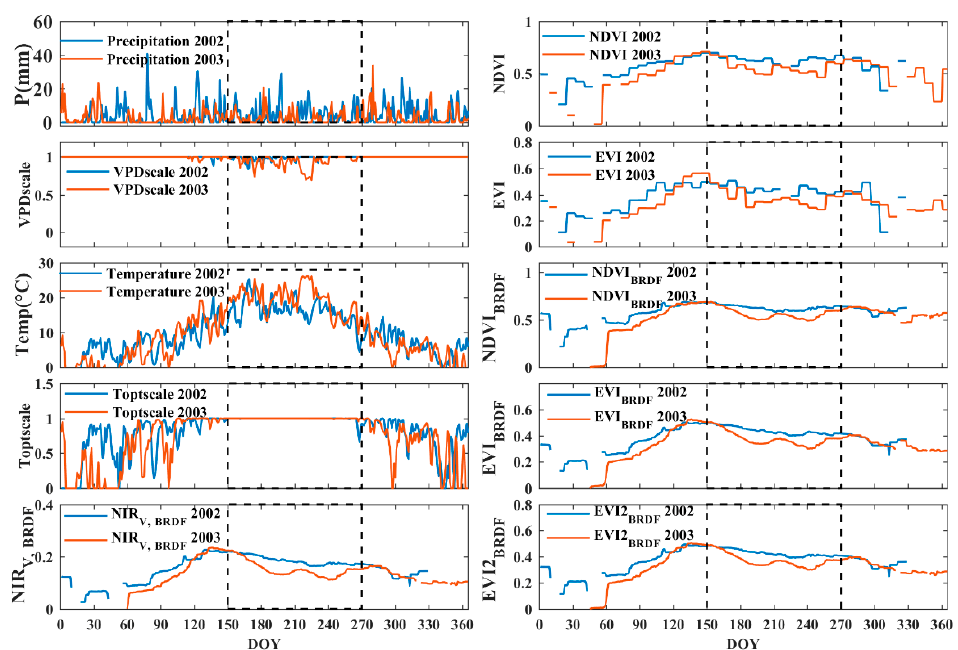
Figure 8. Daily VIs, temperature, precipitation, temperature stress (f Topt ) and water stress (f VPD ) at a grassland site (CH-Oe1) in a normal year (2002) and a drought year (2003).